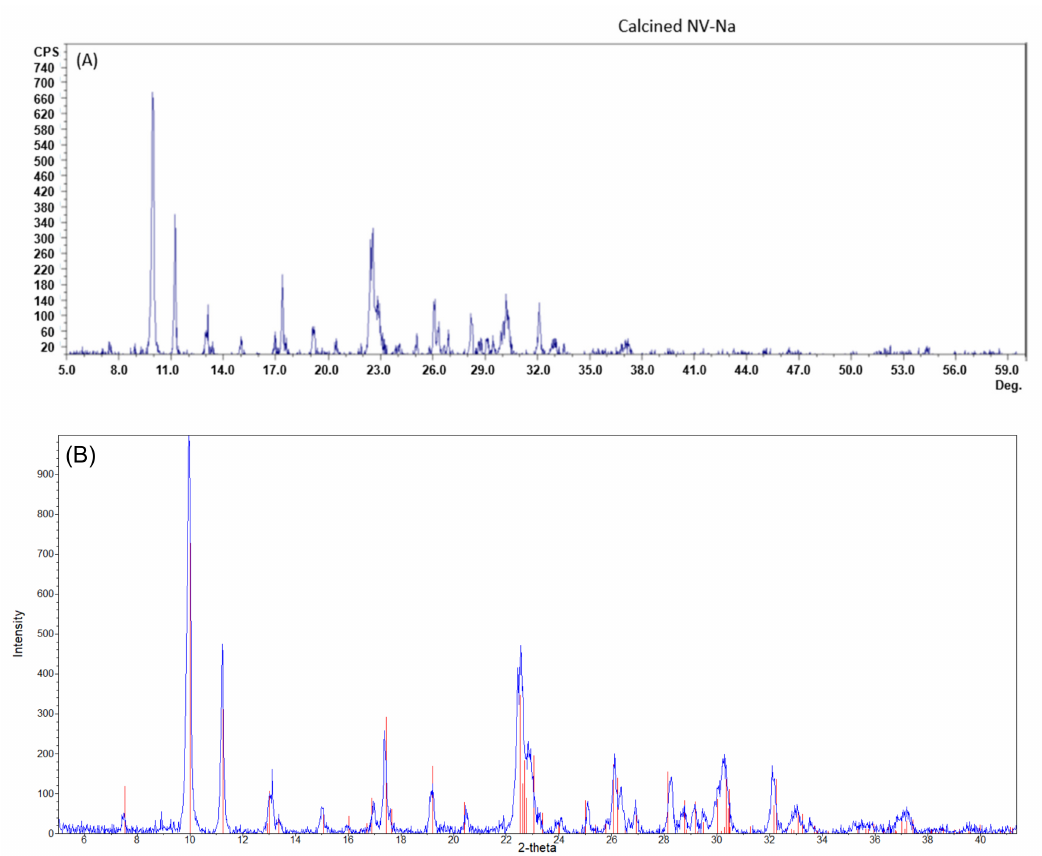
Figure 3. (( A ), above) The XRD pattern of calcined NV-Na. (( B ), below) An expanded drawing of the XRD pattern for calcined NV-Na illustrated using QualX2 [42]. Solid vertical lines represent card [00-900-1391] clinoptilolite-Na at an FoM of 0.75. Raw data converted with PowDLL [43].